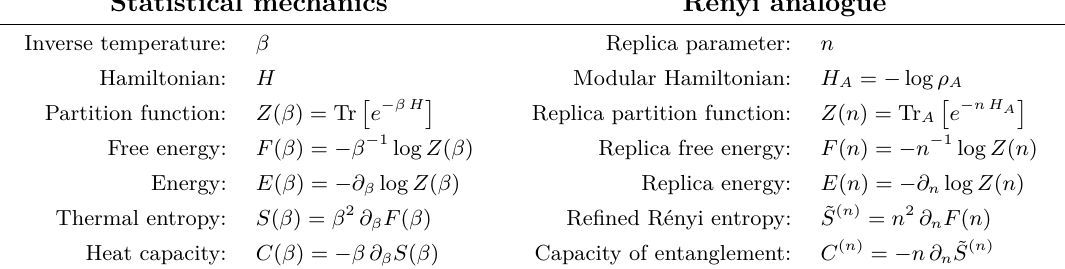
Table 1. An analogy between statistical mechanics and Rényi entropic quantities. ρ A denotes the density matrix associated with a subsystem A . Under the identifications β = n and H = H A , the entanglement entropy and the capacity of entanglement are equivalent to the thermal entropy and the heat capacity,